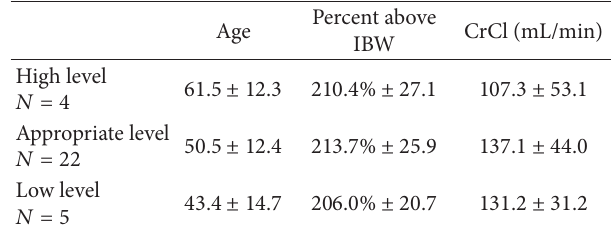
Table 2: Patient-specific data based on achievement